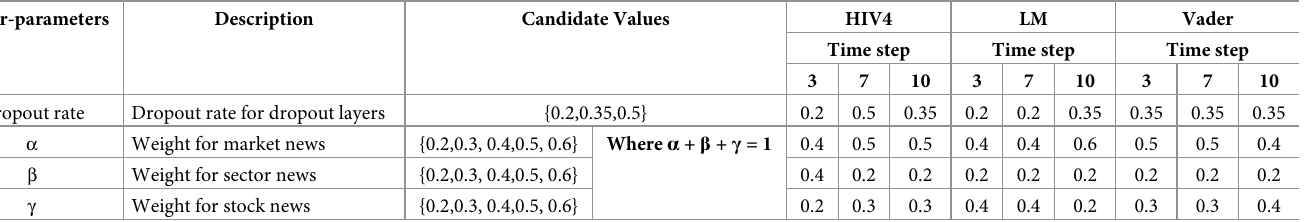
Table 5. WCN-LSTM’s optimized hyper-parameter values.